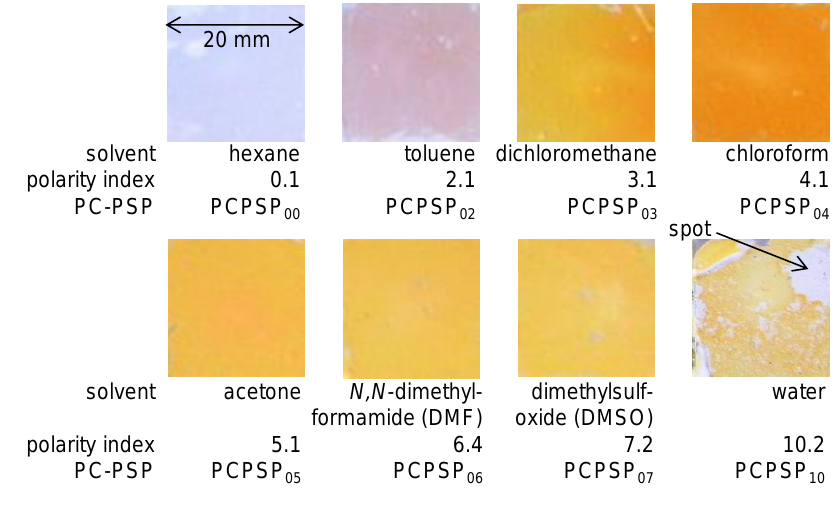
Figure 3. Photographs and identification of PC-PSPs.